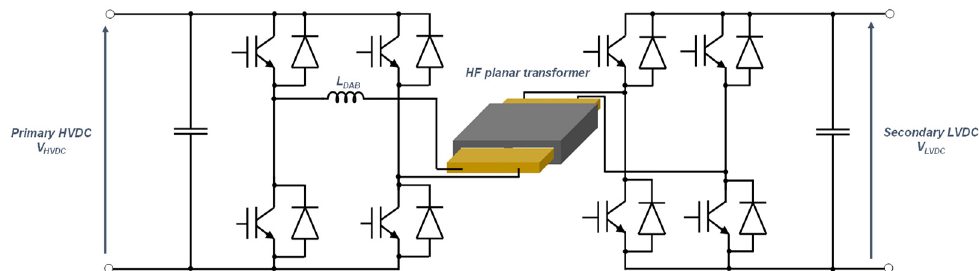
Figure 2. Dual active bridge (DAB) converter. Table 1. Planar transformer electrical specifications.